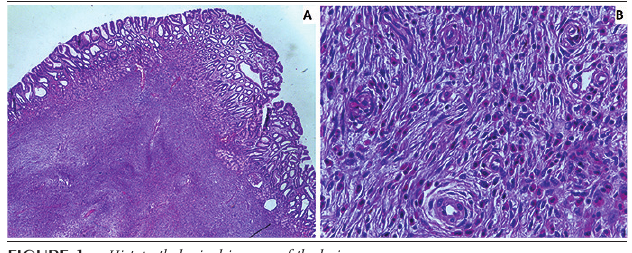
figuRE 1 − Histopathological images of the lesion A) antral mucosa and submucosal IFP (HE, 25×); B) edematous myxoid stroma arranged in concentric layers around blood vessels, and inflammatory background predominantly consisted of eosinophils (HE, 400×).